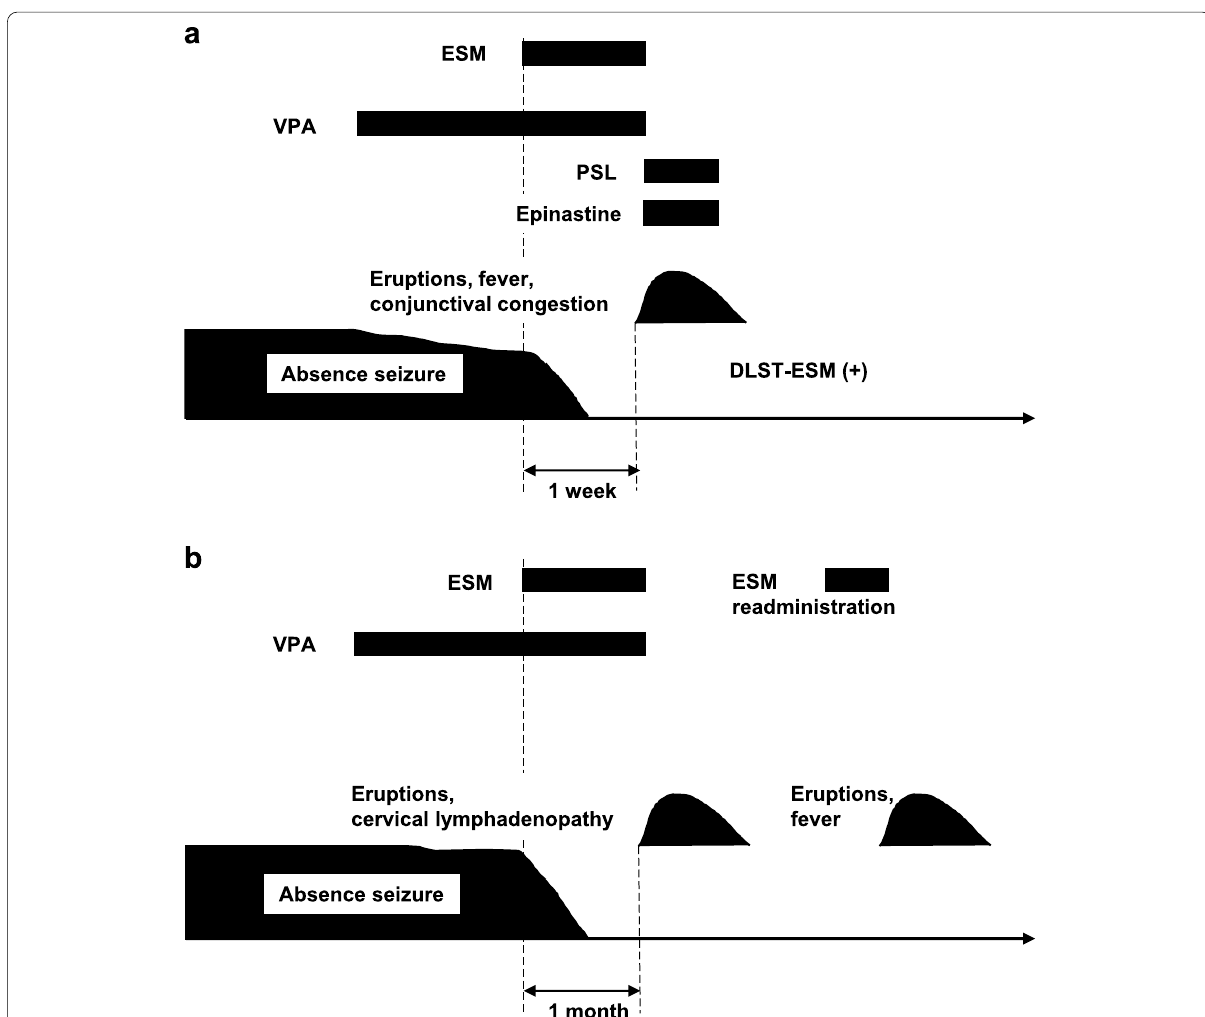
Fig. 2 The clinical courses of case 1 ( a ) and case 2 ( b ). DLST, drug-induced lymphocyte stimulation test; ESM, ethosuximide; VPA, valproic acid;